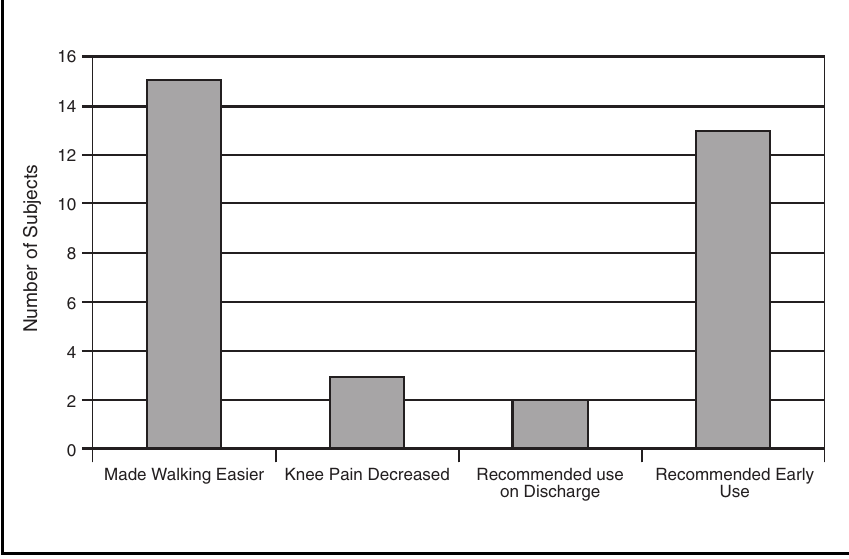
Table 4: p-values of WMPRT and student’s paired t-test of affected and unaffected Leg There was no statistical difference in the step length and stride length for both affected and unaffected leg with and without the use of the FECK brace on the affected side. Figure 1: Subjects’ perceptions of the brace Fifteen subjects indicated that the brace made their walking easier. Three indi- cated that they always had knee pain while walking but the pain eased as they used the brace. All fifteen subjects recommended the use of the brace.